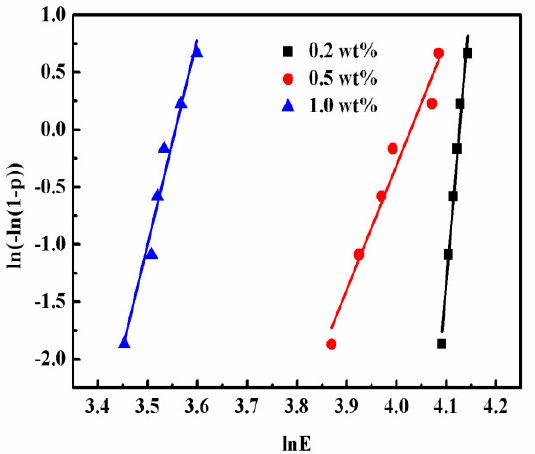
Table 1. Fitting data and Weibull distribution parameters of porous PI films.